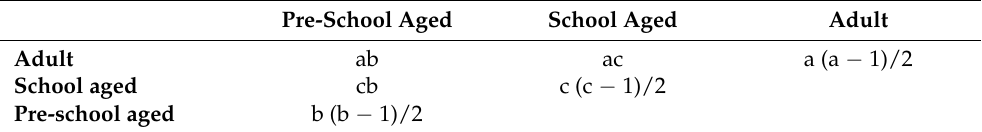
Table A2. Dwelling Contact Matrix: Number of pre-school aged children (b), school-aged children (c) and adults